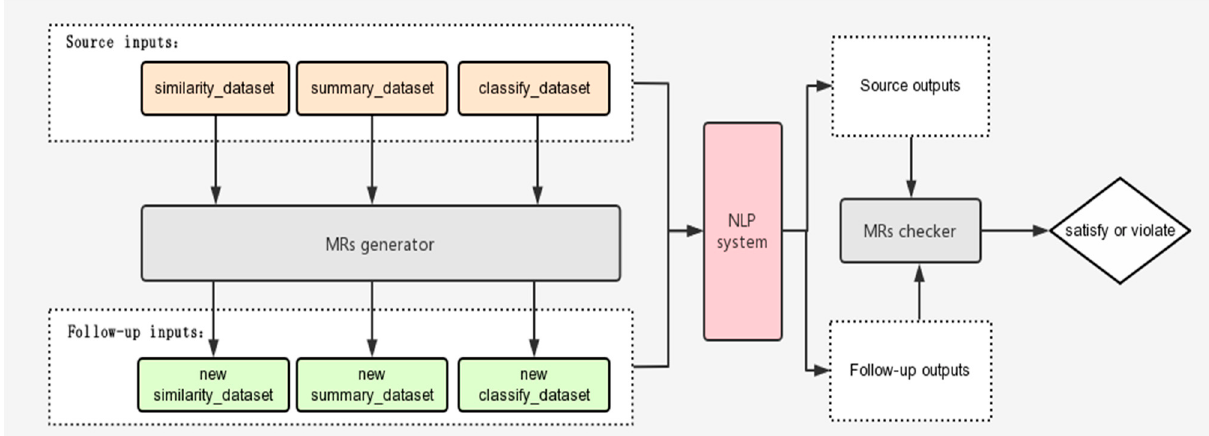
Figure 3. The procedure of evaluating the NLP system based on MT.